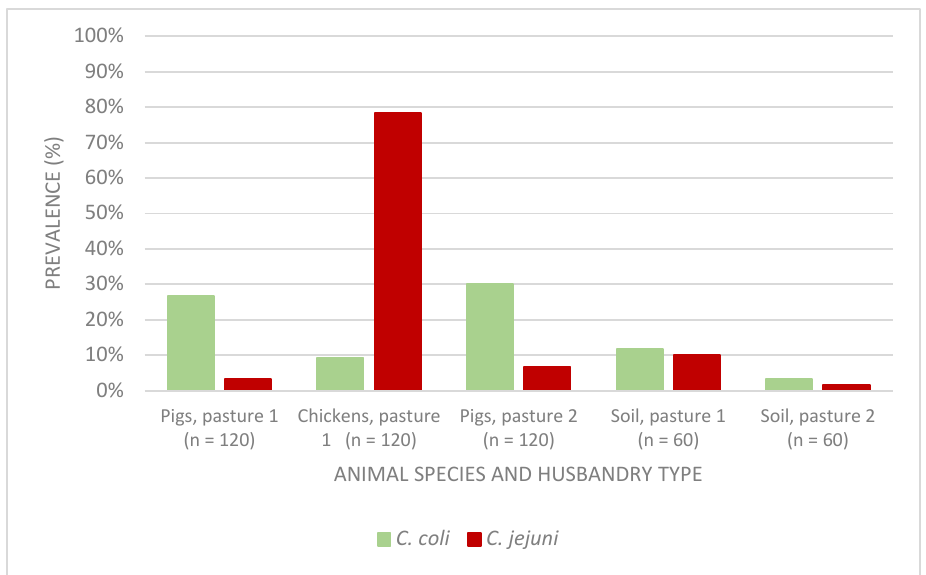
Figure 2. Prevalence of Campylobacter spp. in animal and soil samples from two husbandry types. Pasture 1: pigs and chickens were kept together (mixed husbandry). Pasture 2: pigs alone.